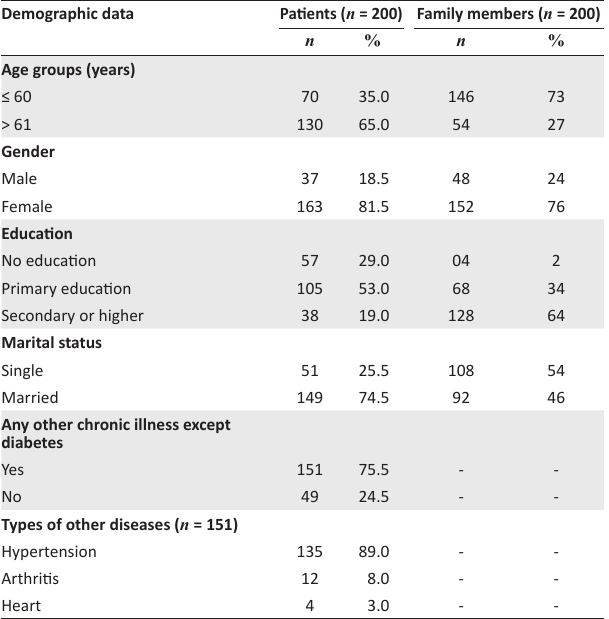
TABLE 1: Demographic profile of respondents.